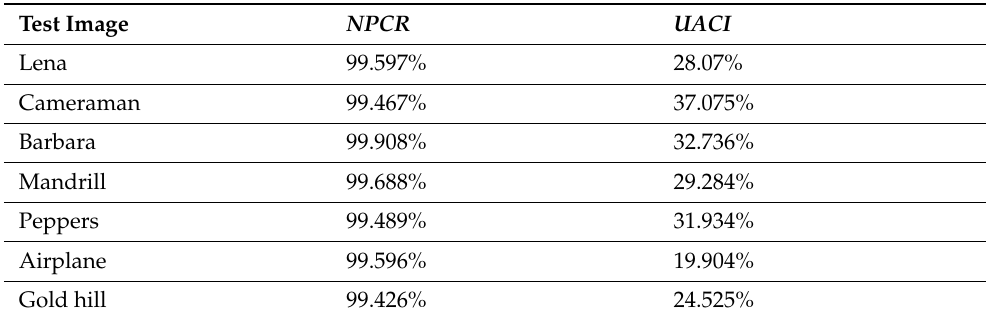
Table 1. NPCR and UACI between Original Test Images and their Scrambled Versions. For any